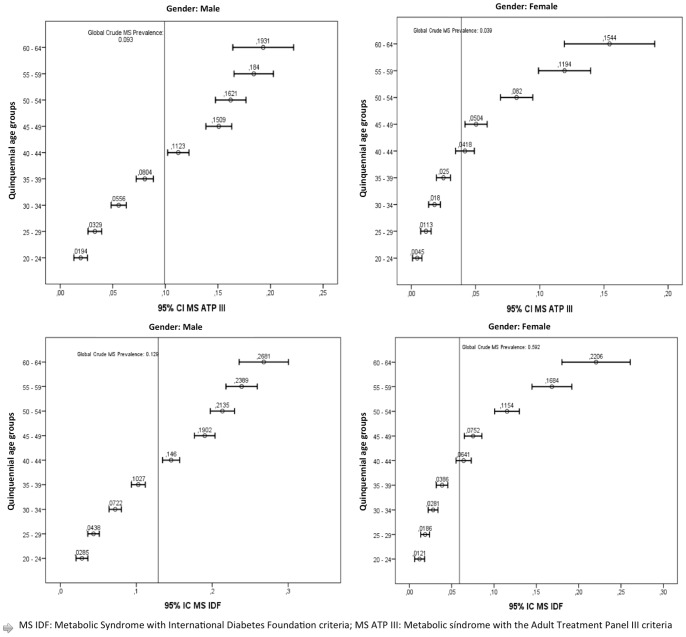
Prevalence of premorbid metabolic syndrome following the ATP III and the IDF criteria by ages (p<0.001).